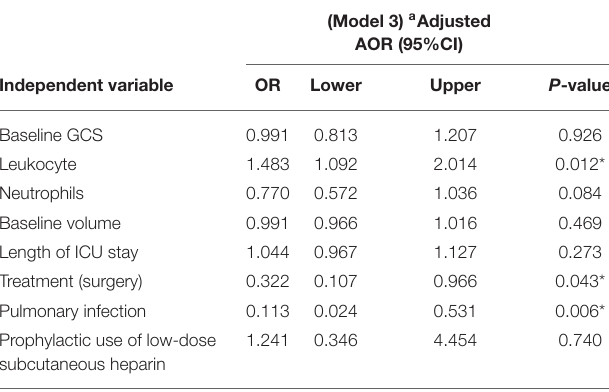
TABLE 3 | Predictors for LEDVT of spontaneous intracerebral hemorrhage in the multivariate model.